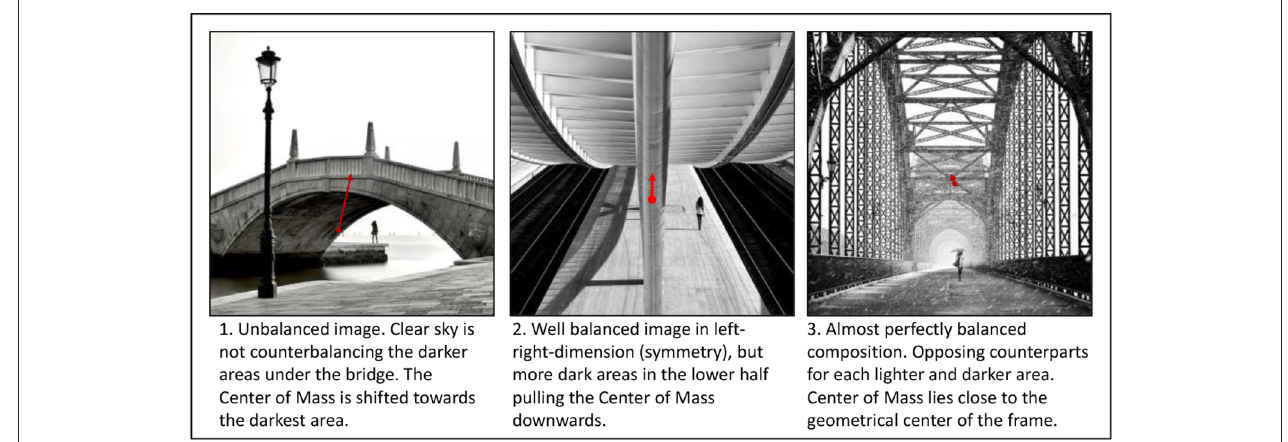
FIGURE A1 | The red dot indicates the objective luminance Center of Mass, according to the DCM measure. The arrow is pointing towards the geometric center of the composition. The shorter the arrow, the better balanced the composition. DCM scores are as follows: Photo 1. BAL DCM 3. BAL DCM 1.54. =